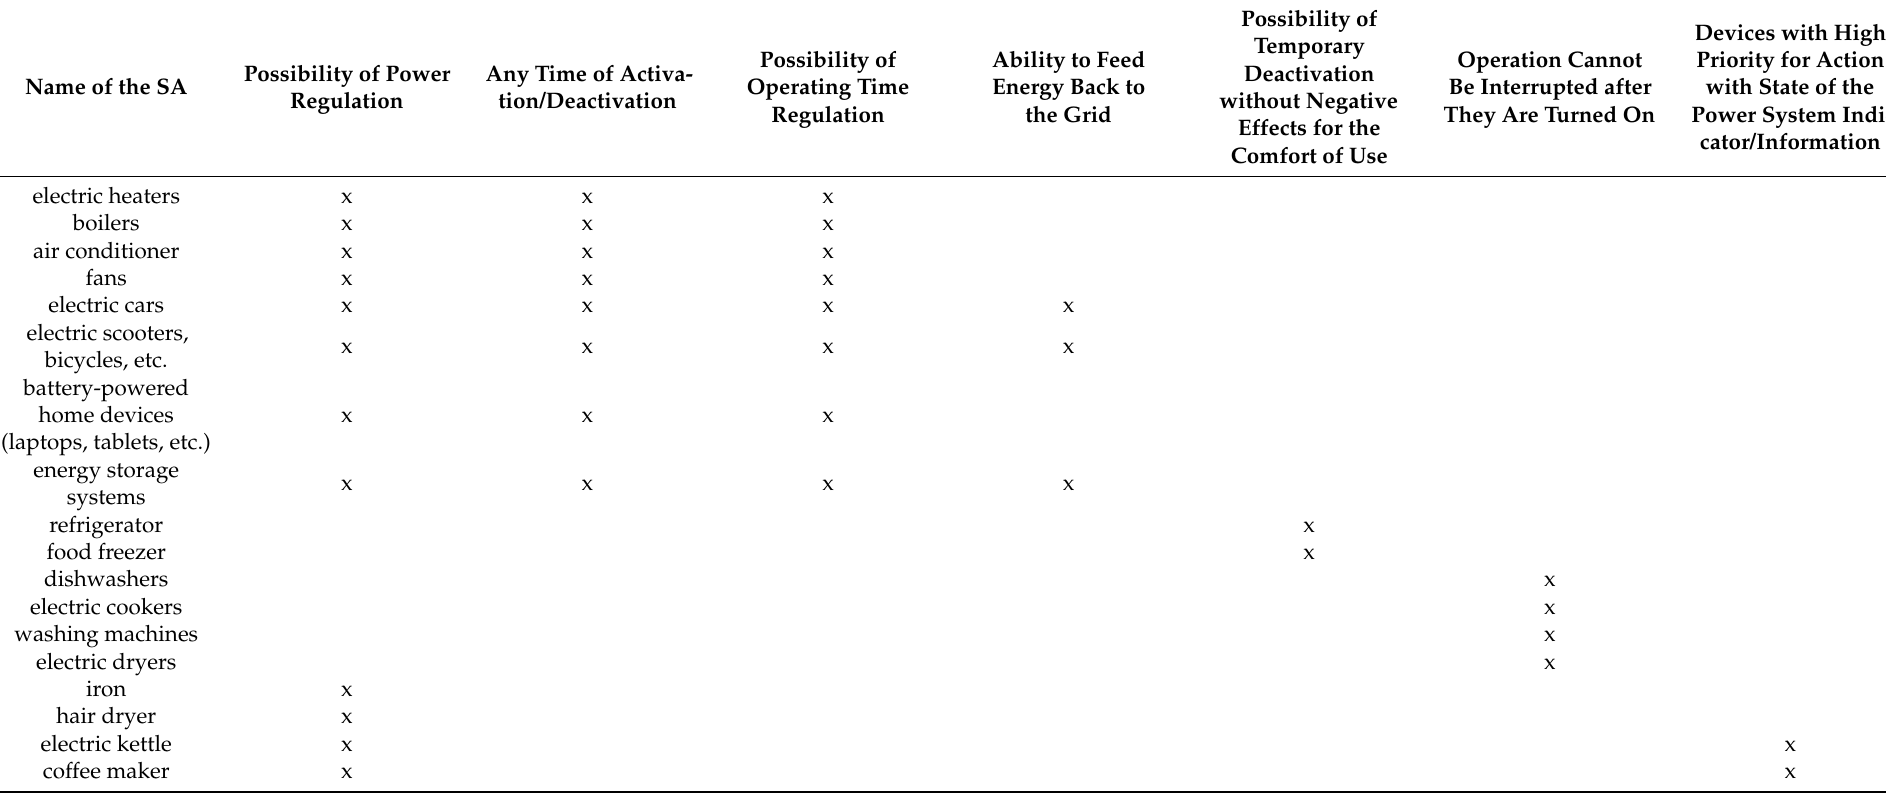
Table 2. Defining functionality for groups of